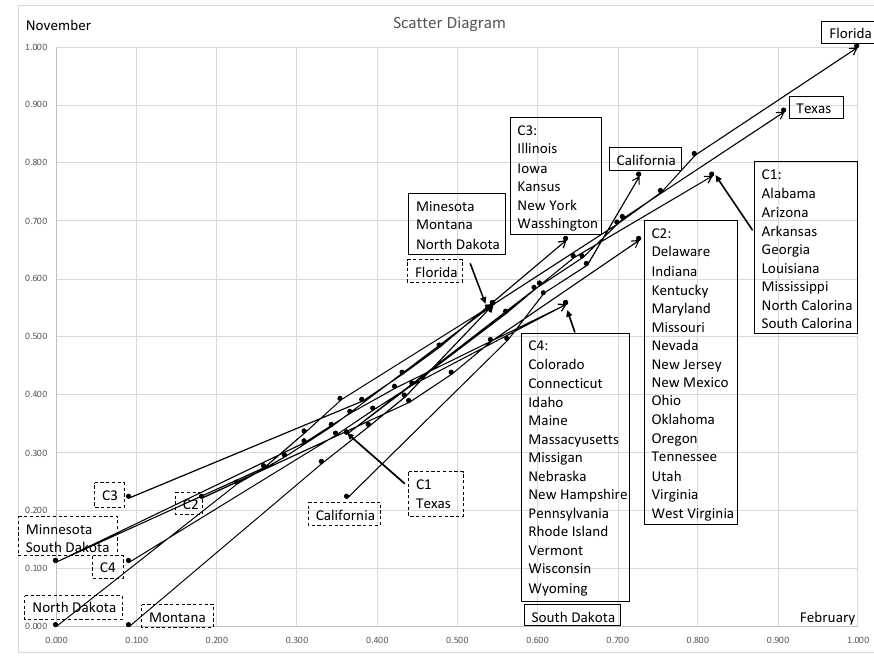
Figure 23. Scatter diagram of four major clusters and seven outliers.